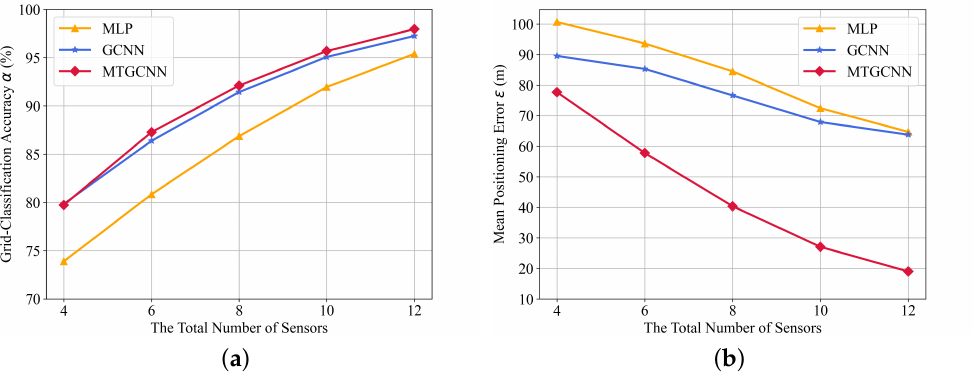
Figure 5. The localization results with a different number of sensors. ( a ) grid-classification accuracy and ( b ) mean positioning error.